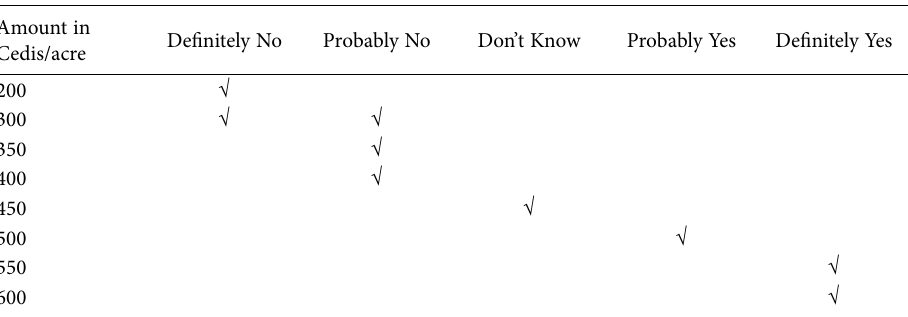
Table 1. An example of an answered CV question. Example: Which of the values would you be willing to accept for constructing STONE BUNDS on an acre of your own field? Please tick only one option for each